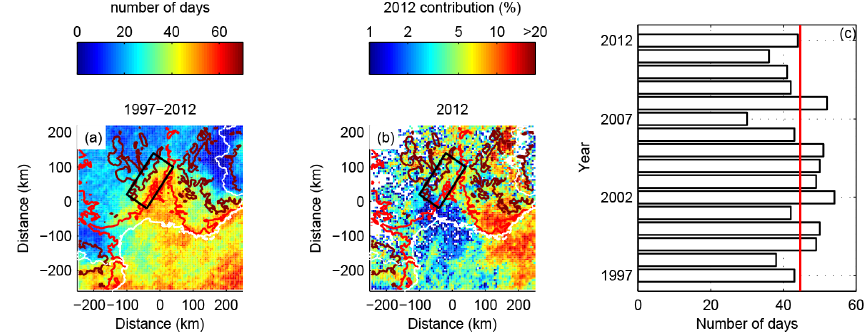
Figure 2. Cloud-to-ground lightning climatology in terms of number of days with at least one cloud-to-ground lightning flash recorded per day in a regular grid of 5km × 5km and cumulated over the period investigated as sensed by Météorage from 1997 to 2012 (a) , contribution of the 2012 records expressed in % relative to the 1997–2012 number of days per 5km × 5km pixel (b) and number of days per year (c) for the period September–November over southeastern France. The red solid line plotted in (c) corresponds to the average value for the 1997–2012 period. Red and black red lines in (a) and (b) indicate 200 and 1000m height, respectively. The Cévennes–Vivarais domain is also delimited by the black